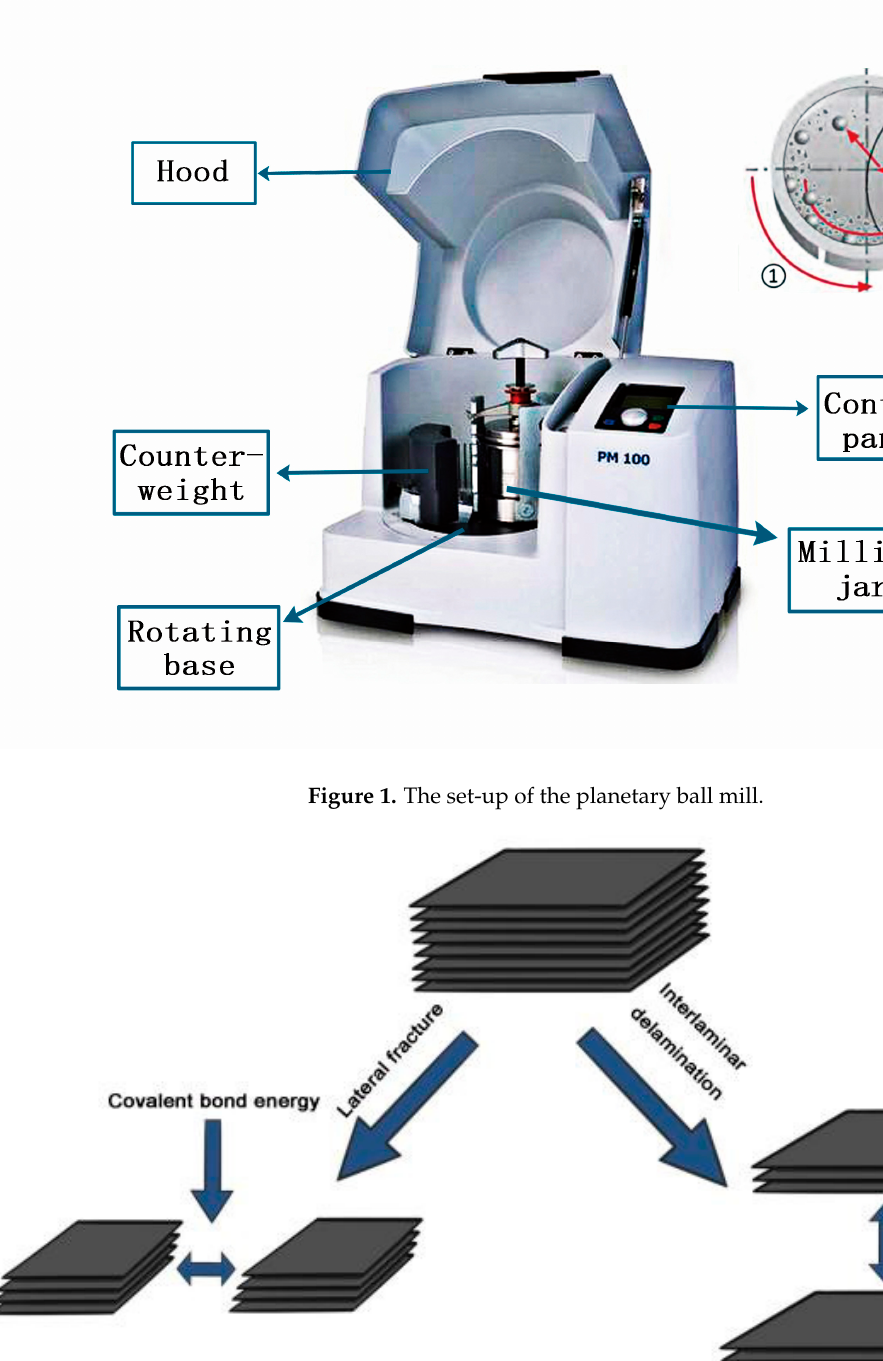
Figure 1. The set-up of the planetary ball mill.